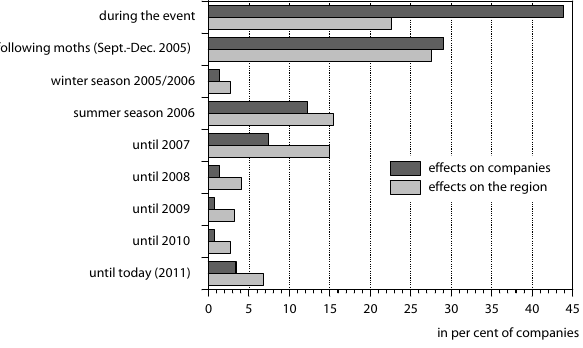
Fig. 5. Companies’ estimates of the duration of the economic im- pacts on companies and on the region; n = 148 for companies, n = 221 for the